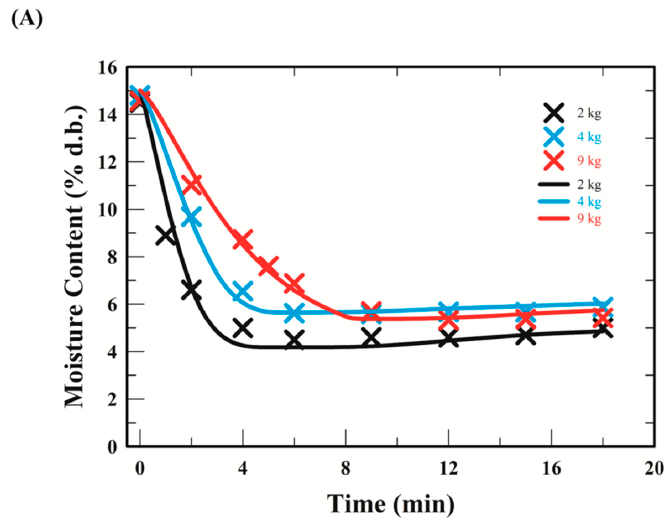
Figure 1. Simulated profiles of the heater temperature during wheat germ (WG) drying. The symbols represent the experimental data; the solid lines represent the simulated values; the dashed line represents the product temperature of 45 °C.